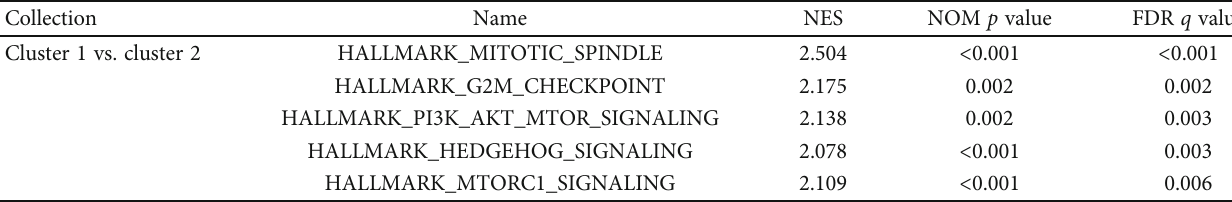
Table 2: Di ff erent pathways between distinct clusters.